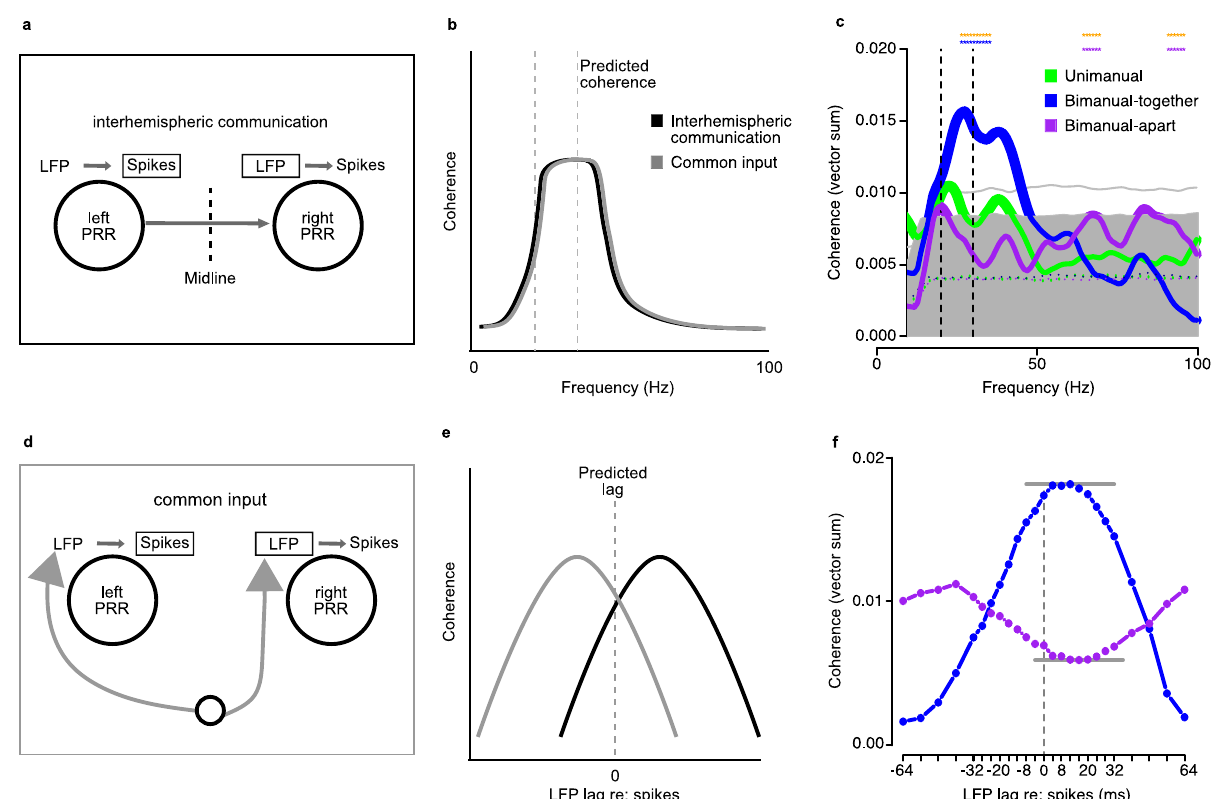
Fig. 5 Interhemispheric beta-band spike-LFP coherence distinguishes between bimanual-together and bimanual-apart movements. a Schematic model depicting local and distal inputs and outputs to and from PRR. Mass input and output of PRR is shown as arrows. The axon terminals of most neurons contact other neurons locally (light gray arrows), but some portion project distally, including to the homotopic area in the opposite hemisphere (dark gray arrows). Connections with non-homotopic areas are omitted for clarity. b Identical spike-LFP coherence predictions under interhemispheric communication scenario (black curve) and common input scenario (gray curve). c From 20 to 50 Hz, spike-LFP coherence is consistently high for bimanual-together movements (solid blue), intermediate for unimanual movements (solid green), and low for bimanual-apart movements (solid purple). The distributions of coherence expected by chance were computed by shuf fl ing interspike intervals. The medians of these distributions are shown as dashed traces. The gray shaded region covers 95% of the values expected by chance; values that exceed this are marked by thickened lines ( P < 0.05). Values exceeding the light gray line are signi fi cant at P < 0.01. Note that there is no effect of movement type on the shuf fl ed coherences. For this reason, data are pooled across movement types for the P < 0.05 and P < 0.01 thresholds. Coherences that are signi fi cantly larger for bimanual-together compared to bimanual-apart are indicated by asterisks (two-tailed t -test, P < 0.05). Dashed vertical lines indicate the beta range (20 – 30 Hz). Coherence was measured during the 800 ms before the go cue. Data are averaged from n = 42 pairs of sites (24 from MkT, 18 from MkZ) recorded simultaneously in the two hemispheres. Only sites with at least 500 spikes are shown. d Schematic model depicting common input to PRR in each hemisphere. Spike-LFP coherence predictions for common input model. e Lagged spike-LFP coherence predictions for direct communication and common input models, respectively. f Extremes of spike-LFP coherence (24 – 38 Hz) occur when spikes lead LFP by 10 – 15 ms (gray lines). Positive and negative x axis values indicate the relative temporal relationship between spike times and the LFP in the original data. Source data are provided as a Source Data fi